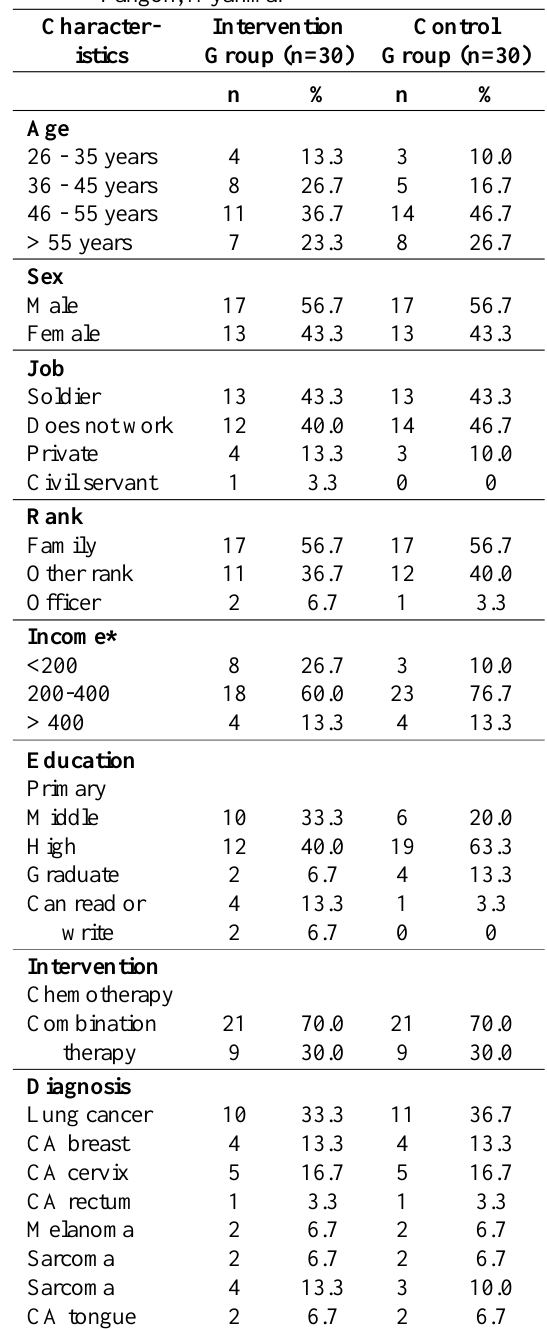
Table 1: Distribution of demographic characteristics of respondents (n= 60) in Oncology